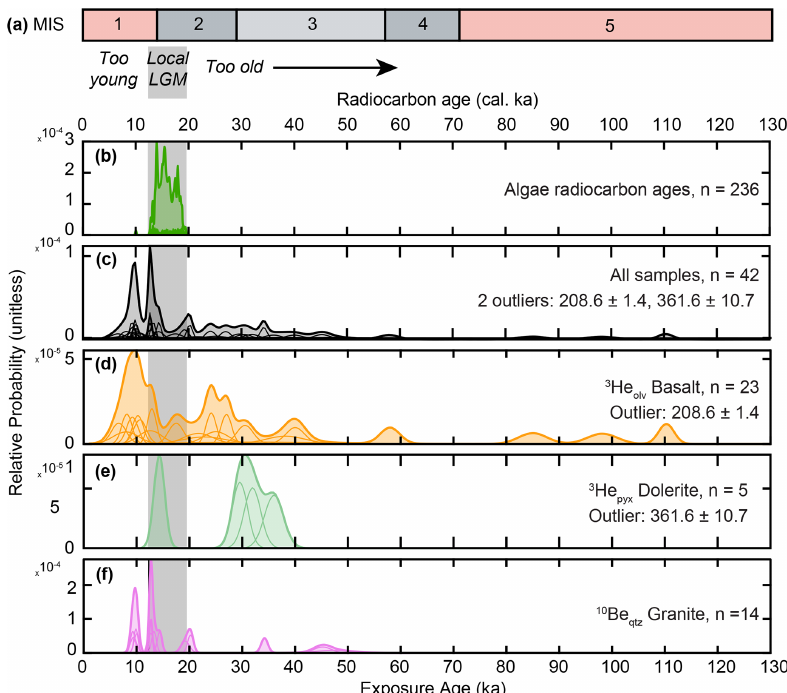
Figure 3. Ross Sea drift age constraints. (a) Marine Isotope Stage (MIS) boundaries and the timing of the local Last Glacial Maximum (LGM) in McMurdo Sound (gray box). Kernel density functions of (b) algae radiocarbon ages, and exposure ages in (c) all samples, (d) 3 He olv in basalt (e) 3 He pyx in dolerite, and (f) 10 Be qtz in granite. Thin lines show Gaussian distributions of individual sample ages and thick lines show the kernel density functions. Outliers are ages >